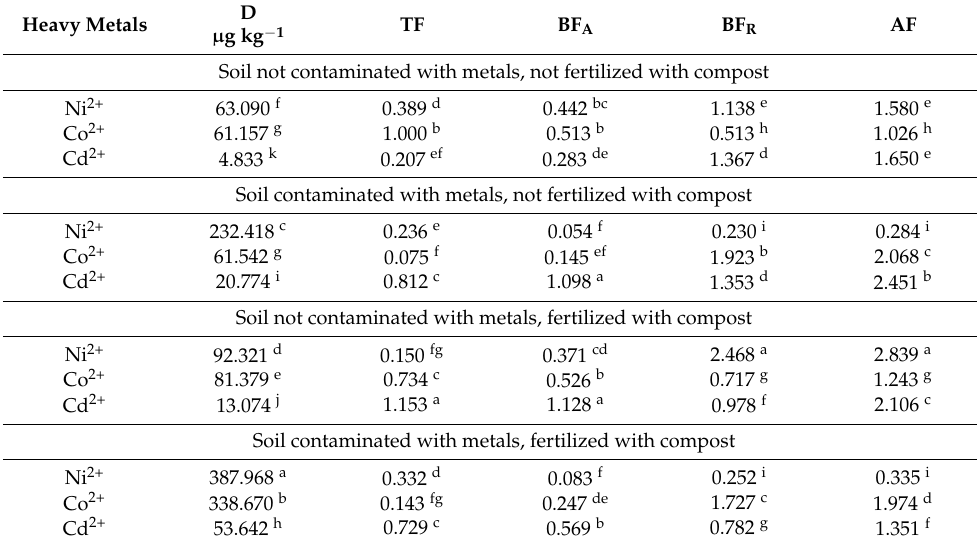
Table 2. Heavy metal uptake (D), translocation factor (TF), bioaccumulation factor in aerial plant parts (BF A ), bioaccumulation factor in roots (BF R ) and accumulation factor (AF).